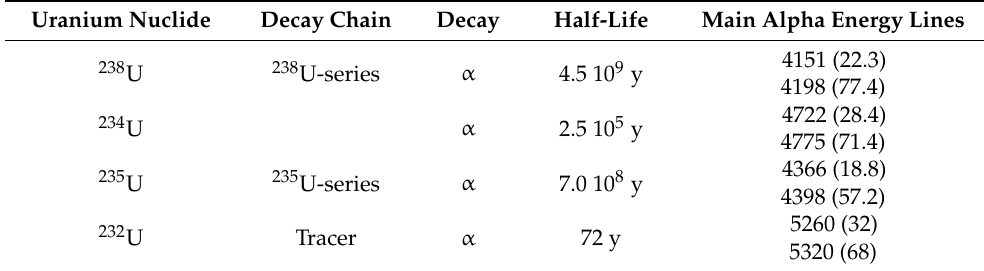
Table 8. Properties of uranium nuclides of the natural decay series and the tracer 232 U. Alpha energy lines in keV with emission probability in %. All data from